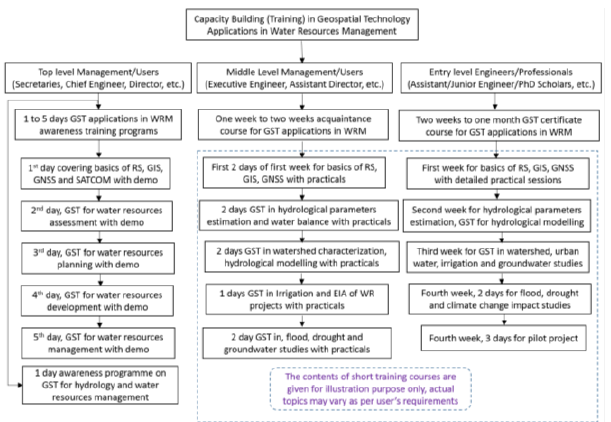
Figure 4. Overall structure of multi-level training in GST applications in hydrology and